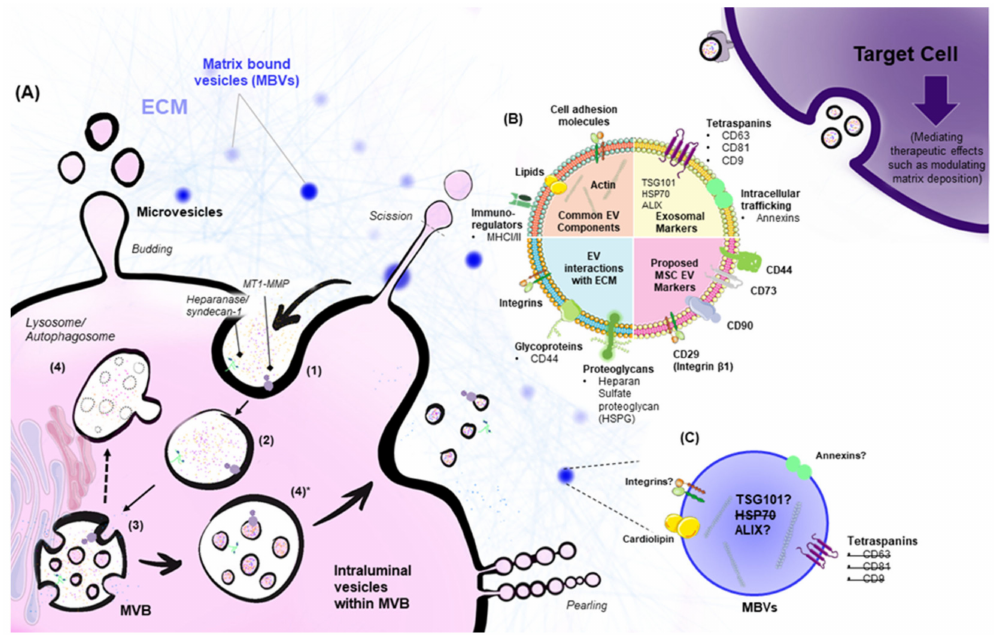
Figure 1. Extracellular Vesicle biogenesis and features. ( A ) Microvesicles or ectosomes form via outward budding of the plasma membrane, pearling, and subsequent scission. (1) Endocytosis of extracellular components results in the formation of an early sorting endosome. Extracellular matrix proteins such as syndecan and other transmembrane proteins such as MT1-MMP can also be endocytosed, and subsequently associate with forming intraluminal vesicles [27]. The early endosome (2) then matures into a late sorting endosome that exchanges its cargo with intracellular constituents such as the trans-Golgi network and the endoplasmic reticulum. (3) The involution of the membrane of the endosome (late sorting endosome) results in the formation of intraluminal vesicles. A multivesicular body with multiple intraluminal vesicles faces three fates: (4) starvation, followed by fusion with autophagosome, fusion with lysosomes, or (4)* docking onto the plasma membrane and fusing to release contents as exosomes. Following their release, EVs traverse the ECM to interact with target cells or are transported in biological fluids. EV-target-cell interactions take place through various mechanisms. Entry of intact exosomes can occur via receptor-mediated endocytosis, phagocytosis, micropinocytosis, clathrin-mediated entry, caveolae, or lipid-raft-mediated endocytosis [3,28]. Alternatively, exosomes can fuse directly with their target cells, or mediate intracellular signaling by direct-receptor binding. After they interact with target cells, EVs can mediate therapeutic effects that involve ECM protein regulation. Common exosomal markers and EV properties are outlined in ( B ), along with EV components that interact with the ECM. Proposed EV MSC markers are outlined [29]. There is a subpopulation of EVs within the ECM (MBVs). MBVs are enriched in actin and cardiolipin, but it is not clear whether they are enriched in other common exosomal or microvesicle markers such as Annexin A1 [30]. As depicted in ( C ), MBVs do not express key exosomal markers; these absent markers are struck out with a line. The figure is adapted from [3,9,21]. MT1-MMP: Membrane-type matrix metalloproteinase; EVs: Extracellular vesicles; ECM: Extracellular matrix; MSC: Mesenchymal stem cell; MBVs: Matrix-bound